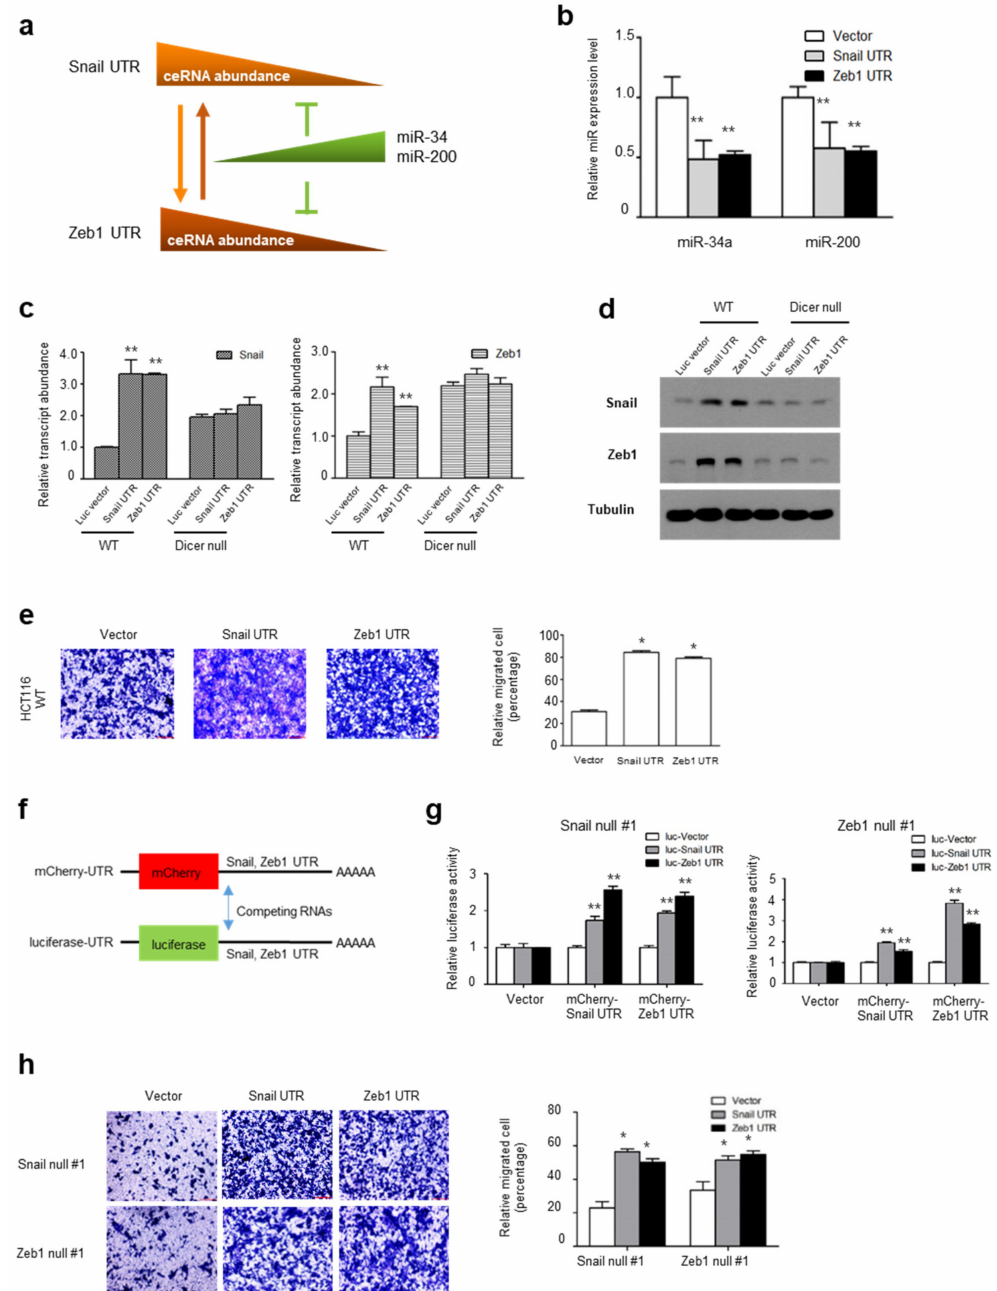
Figure 3. UTRs could play a role in ceRNA regulation: ( a ) Proposed schematic model of regulation between a ceRNA set and miR family; ( b ) Relative miR-34a and miR-200 expression levels in HCT116 cells following transfection with UTR expression vector of Snail and Zeb1; ( c ) qPCR analysis of Snail and Zeb1 mRNA expression in HCT116 wt and Dicer-null cells expressing Snail and Zeb1 UTR; ( d ) Immunoblot analysis of Snail and Zeb1 in HCT116 wt and Dicer-null cells expressing Snail and Zeb1 UTR (** p < 0.01 compared with vector control, t -test). Representative blots are shown from at least two independent experiments; ( e ) Representative migration images (left panel) and the number of migration cells (right panel) in HCT116 cells expressing Snail and Zeb1 UTR. The number of migration cells. Results are representative of five independent experiments (* p < 0.05 compared with control, Mann–Whitney test); ( f ) Schematic representation of the experimental ceRNA effects on UTRs; ( g ) Luciferase activity in Snail or Zeb1-null HCT116 cells transfected with control or UTR vector (** p < 0.01 compared with control, t -test); ( h ) Representative migration images (left panel) and the number of migration cells (right panel) in Snail or Zeb1-null HCT116 cells (* p < 0.05 compared with control, Mann–Whitney